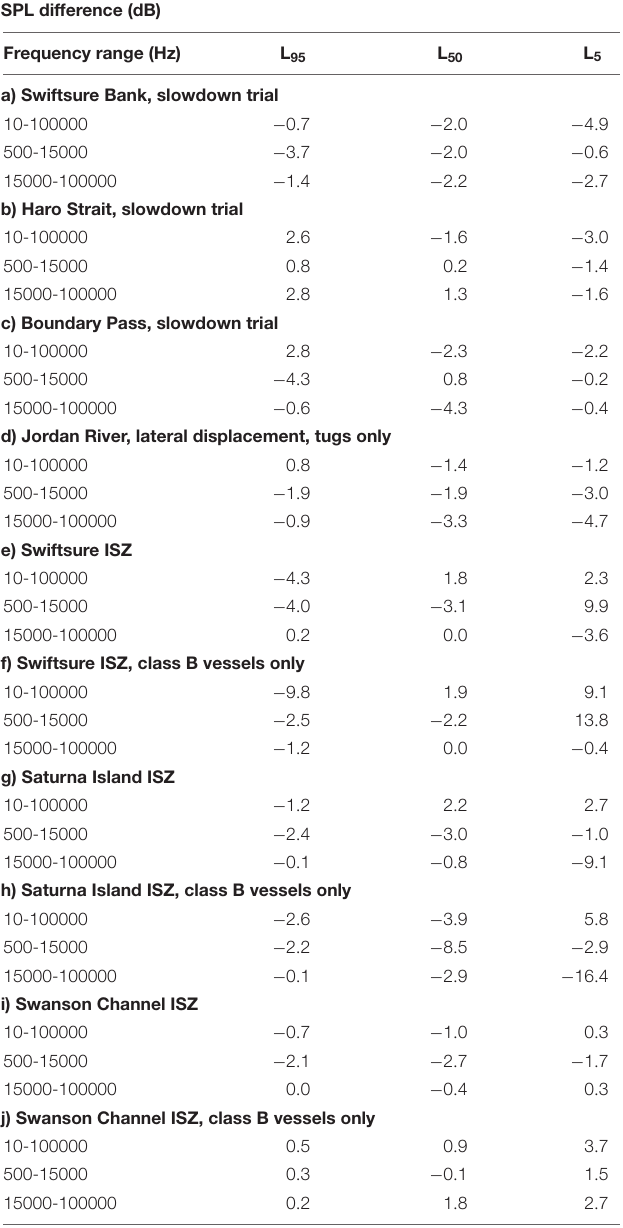
TABLE 3 | The differences in SPL between pre-trial and trial periods at the L 5 , L 50 , L 95 exceedance levels are shown for frequency ranges important to SRKW communication (500 Hz to 15 kHz) and echolocation (15–100